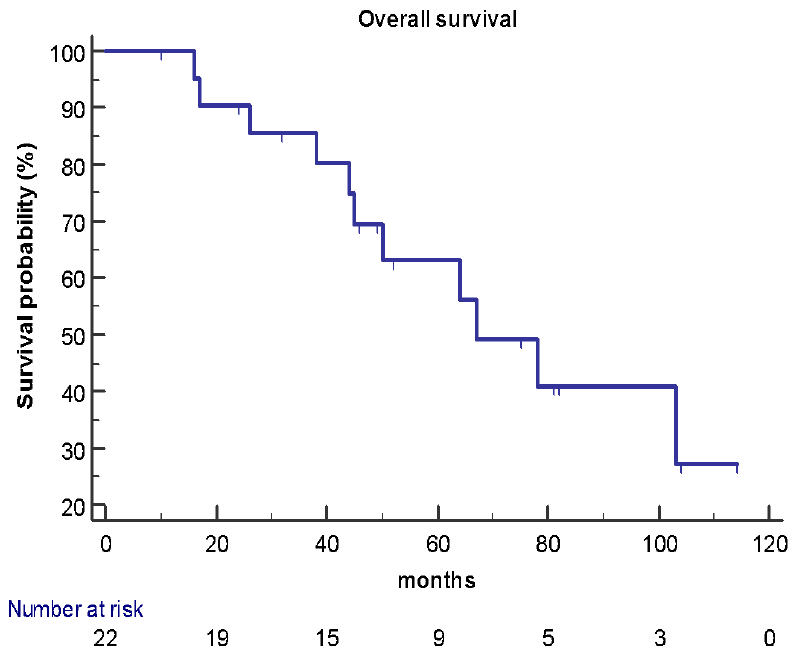
Figure 1. OS in the study population ( n = 22): median OS was 67 months (95% CI 45–103).